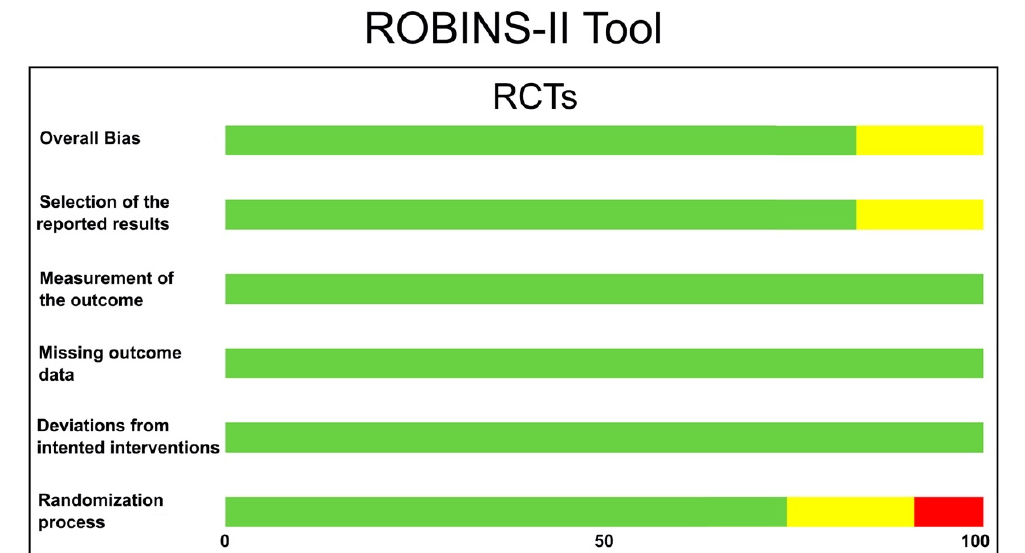
Figure 3. Quality evaluation of the RCTs using the RoB 2 tool (Cochrane Collaboration). The risk of bias in the included studies was classified as either low (green), some concerns (yellow) or high (red).